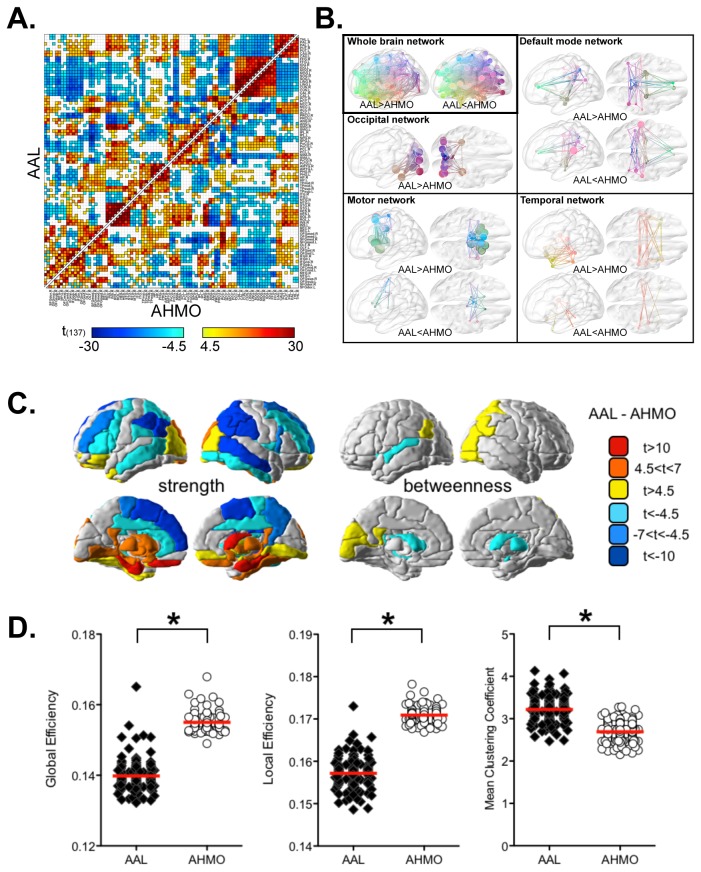
Biased estimation of functional connectivity and graph theoretical properties in the AAL.(A) Elements in upper- and lower- triangular matrix represent functional connectivity maps (adjacency maps) using the AAL and AHMO (regionally averaged corresponding to the AAL map). (B) Functional connectivity difference between the AAL and AHMO. (C) Statistical difference in nodal strength and betweenness centrality between the AAL-based network and AHMO-based network. (D) Global and local efficiency are lower in the AAL than in the AHMO, while mean clustering coefficient is higher in the AAL than in the AHMO. Significance was determined at p<0.05 (Bonferroni corrected for all comparisons).